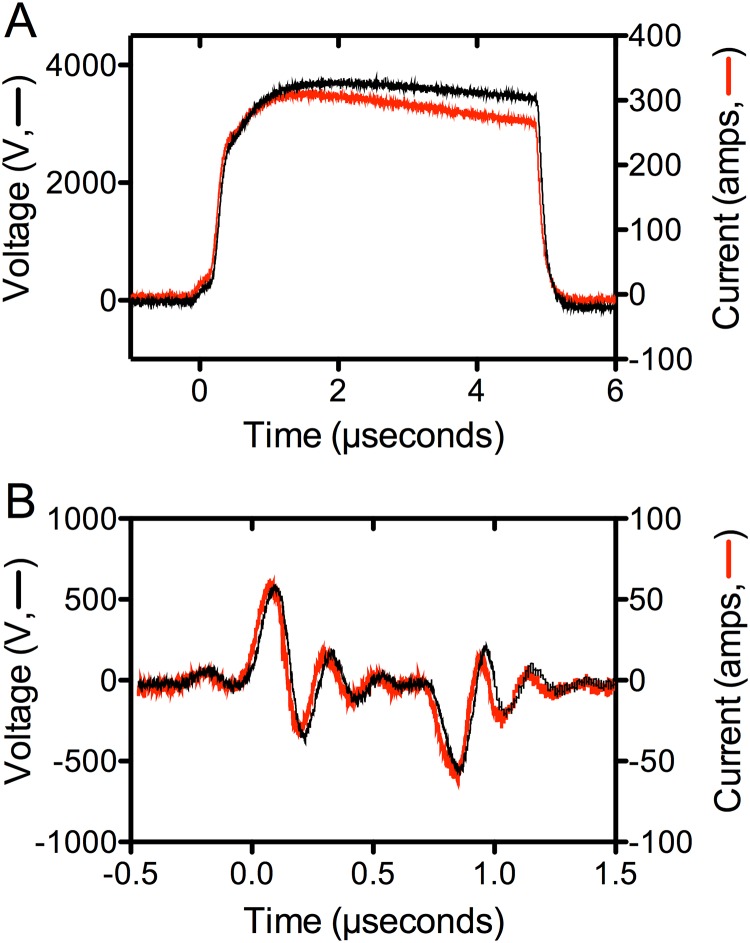
Representative electrical tracings for PEF A (A) and PEF B (B).